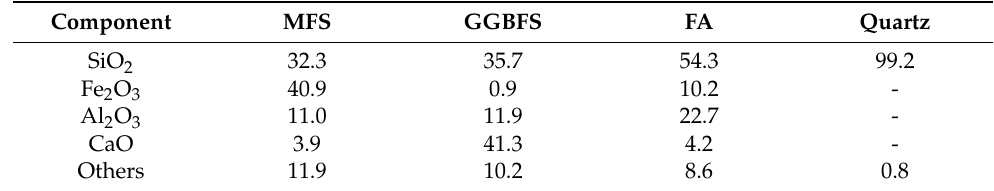
Table 3. Chemical composition of the starting materials in wt.%. GGBFS: Ground granulated blast-furnace slag; FA: Fly ash.